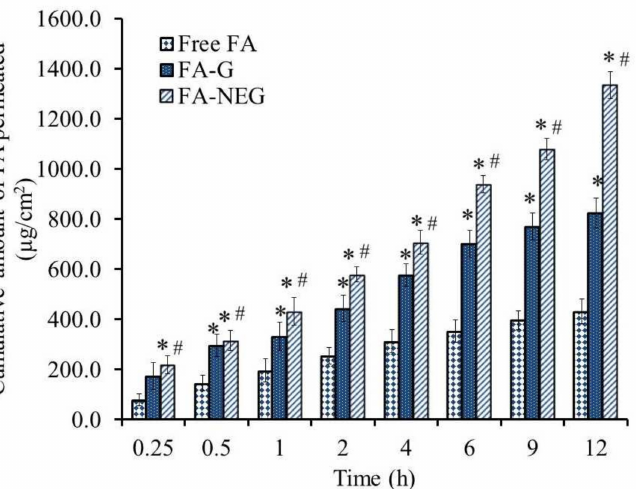
Figure 12. Ex vivo permeation study profile of FA from diverse preparations (free FA, FA-G, and FA-NEG) across a rat skin membrane. Results are expressed as means ± SD ( n = 3); * p < 0.05 compared to free FA; # p < 0.05 compared to the FA-G